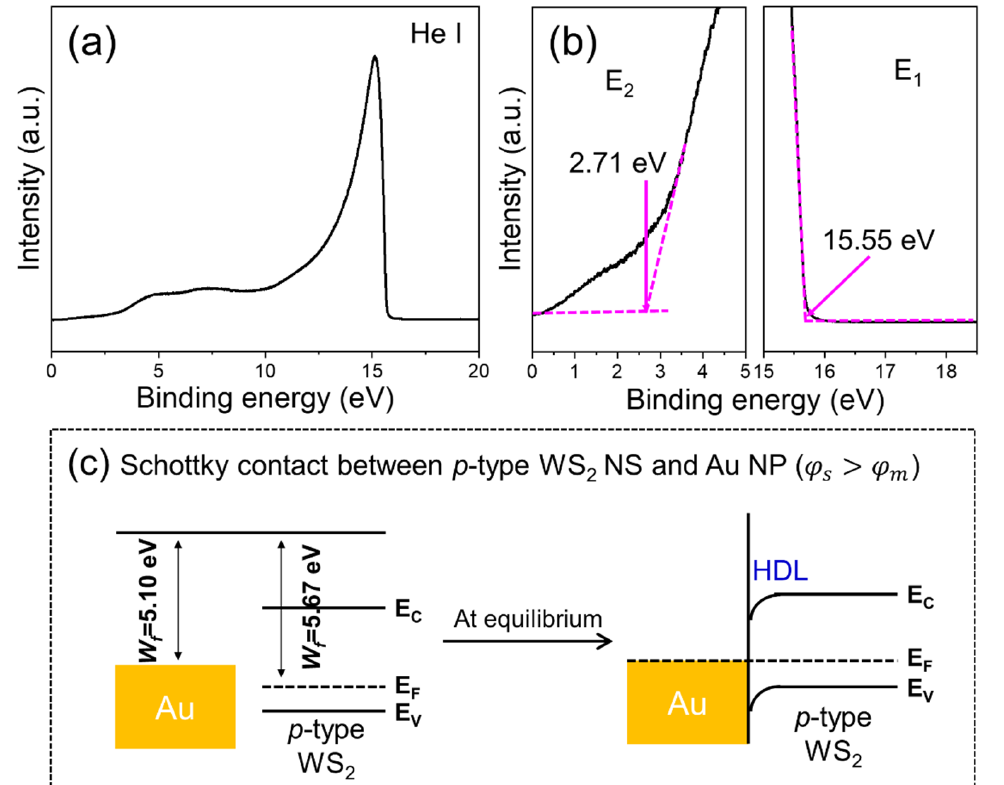
Figure 9. ( a ) UPS spectra of WS 2 NSs. ( b ) Corresponding energy cut off values of WS 2 NSs. ( c ) Band structures of WS 2 NSs and Au NPs before and after intimate contact.